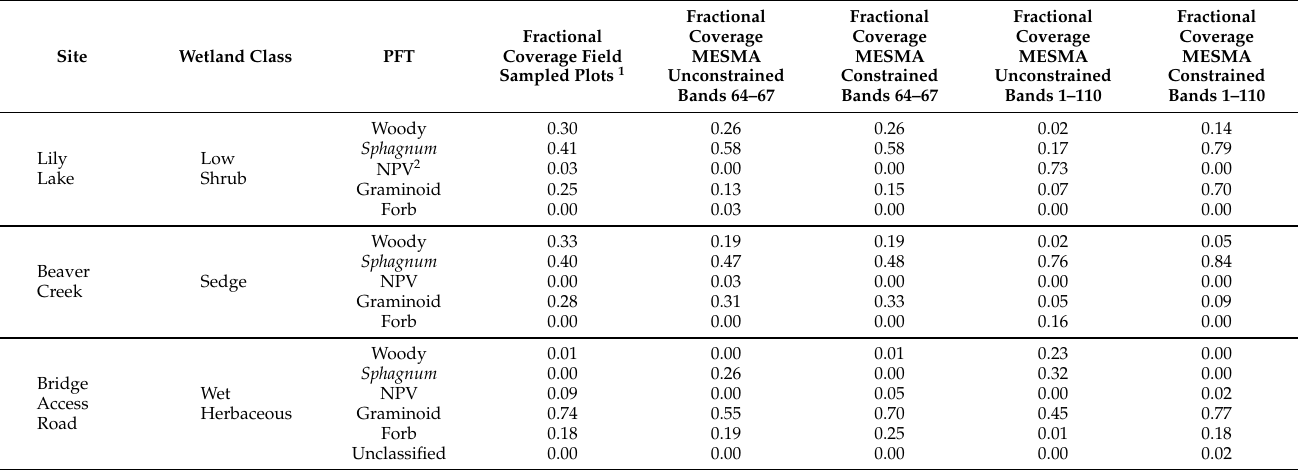
Table 7. Comparison of the statistical results for PFT constrained and unconstrained MESMA for the small, predicted swaths of the three wetland sites using 4-band and 110-band IES-pruned